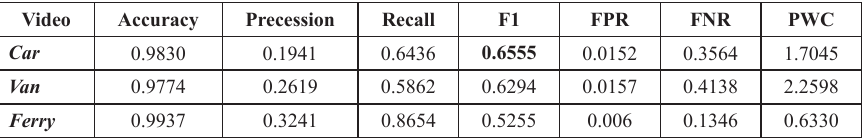
Table 6. Performance metrics results of applying KNN model